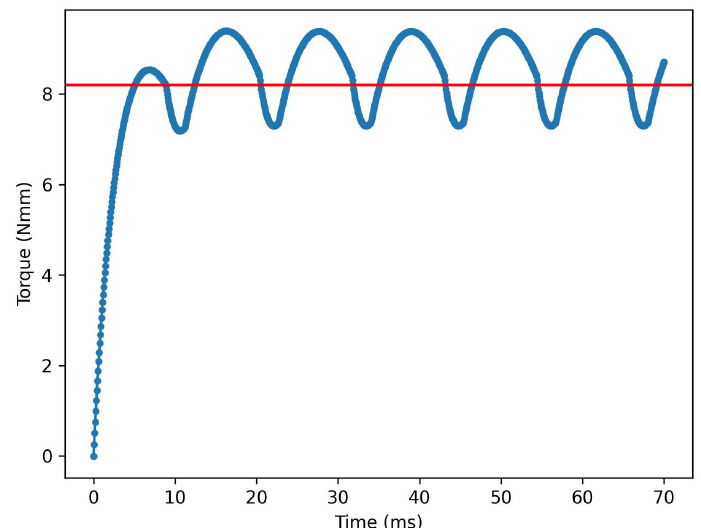
Figure 9. Torque generated by PMBLDC motor model under 6.7 A DC current source.